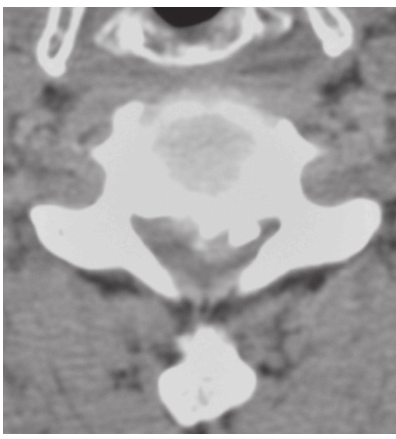
Figure 1: CT-scan transverse cut at the C5-6 level. Segmental type ossified posterior longitudinal ligament on the left side, with adjacent soft tissue mass protruding into the spinal canal.